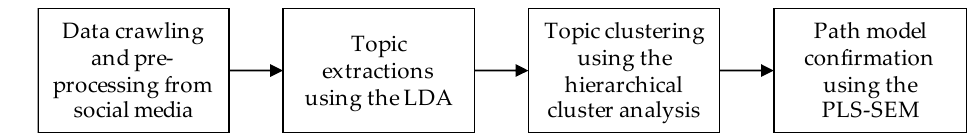
Figure 2. Research Framework.